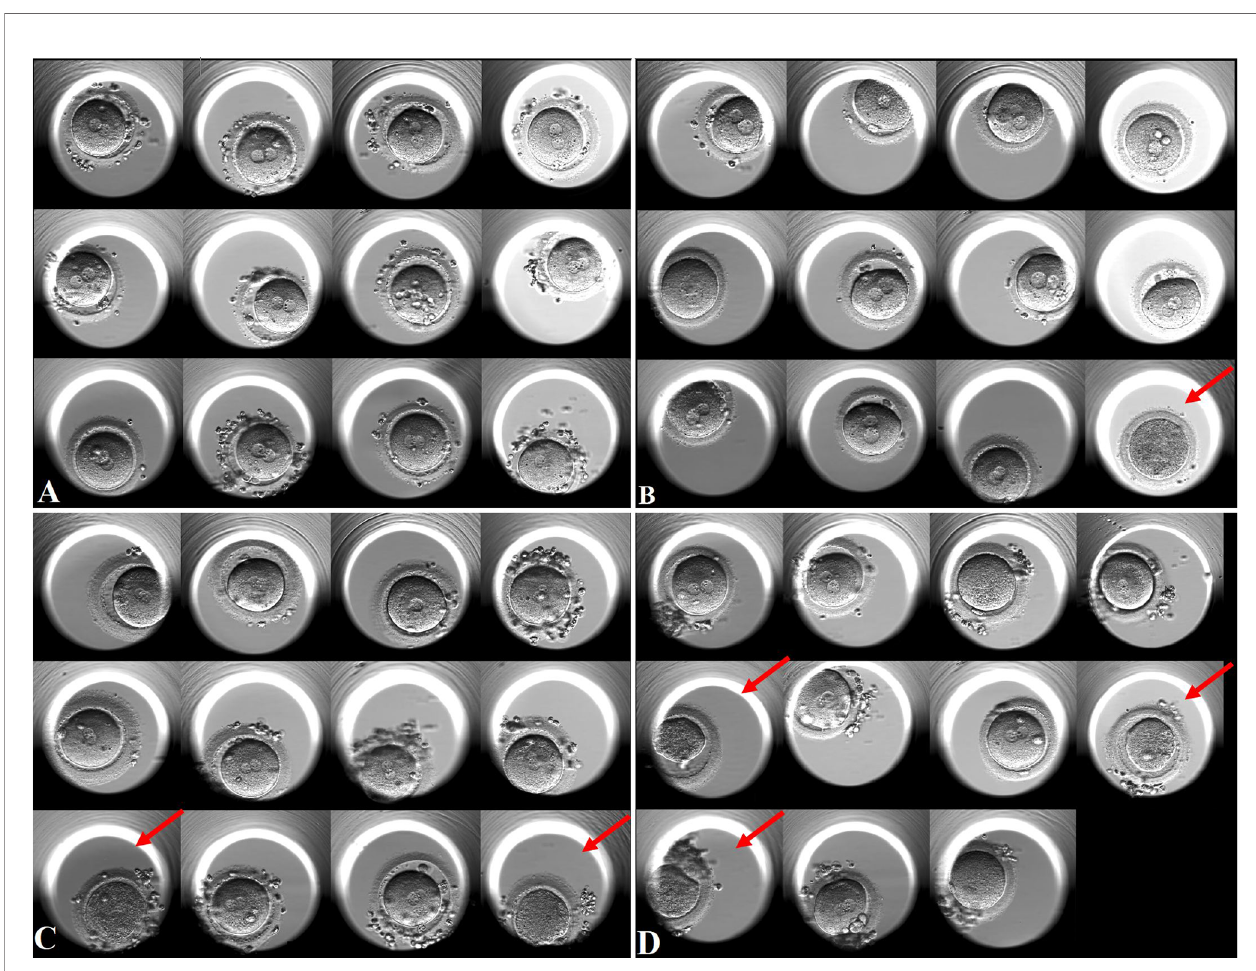
FIGURE 3 | Oocyte images on Day 1 with different oocyte degeneration rates (ODR: 0, <10%, 10-20%, and >20%). Red arrow presents degenerated oocytes. (A) non-OD group(ODR 0). (B) ODR (<10%) subgroup. (C) ODR (10-20%) subgroup. (D) ODR (>20%)